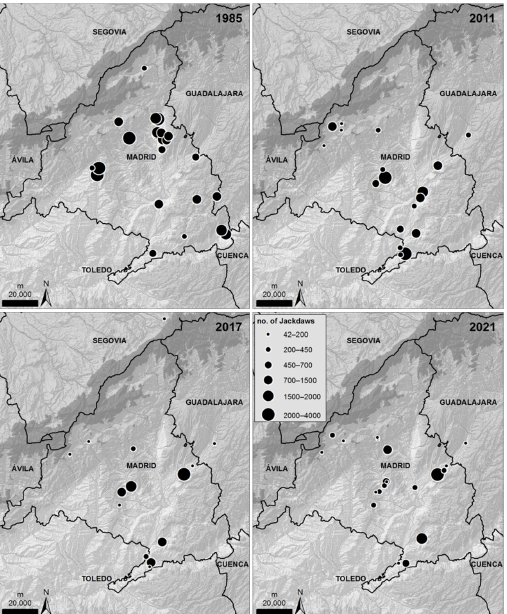
Figure 6. Distribution and size of communal roosts of jackdaws during the non-breeding season in Madrid province, Central Spain. Data refer to simultaneous counts in mid-December 2011 [54], 2017 and 2021, including individuals foraging in neighbour provinces (Segovia, Toledo, and Guadalajara) but roosting in Madrid, or vice versa. Data from 1985 [61] refer to non-simultaneous counts partially covering the study area in autumn and winter. Conservation 2022 , 2 , FOR PEER REVIEW